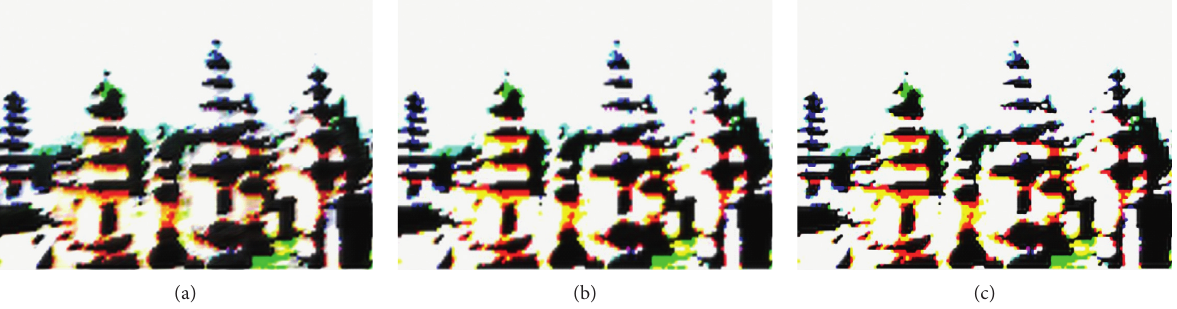
Figure 5: The effect of virtual color restoration of different algorithms. The effect of (a) Criminisi algorithm on cultural heritage architectural image restoration, (b) virtual color restoration of deep learning algorithm, and (c) virtual color restoration of this algorithm.